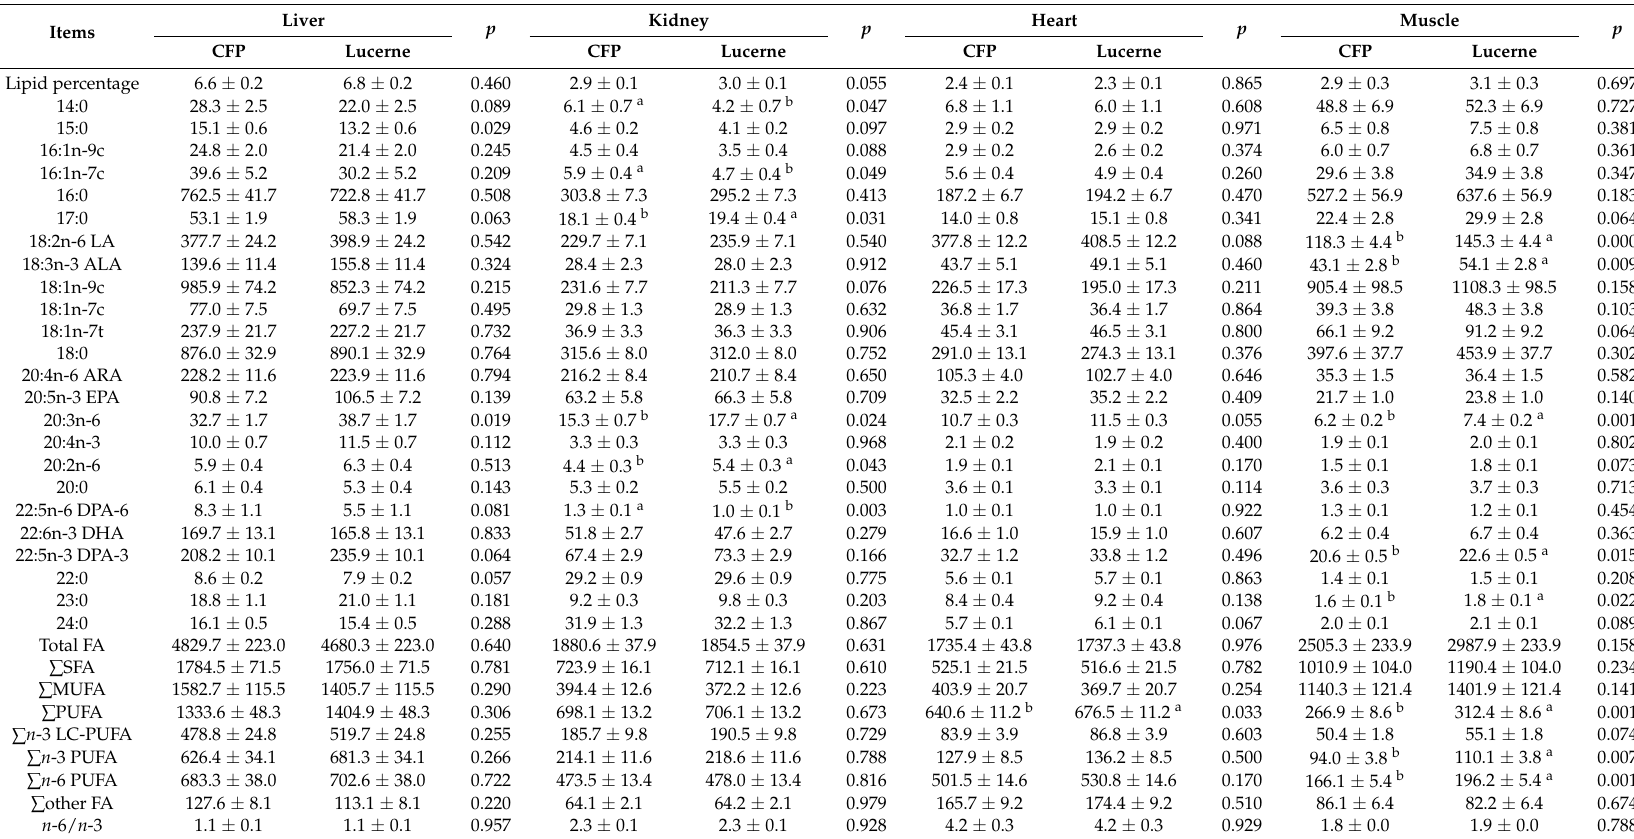
Table 7. Effect of different pasture types on total lipid percentage (g fat/100 g) and fatty acid contents (mg/100 g) in liver, kidney, heart and Longissimus dorsi muscle of prime lambs (LSM ± SE)